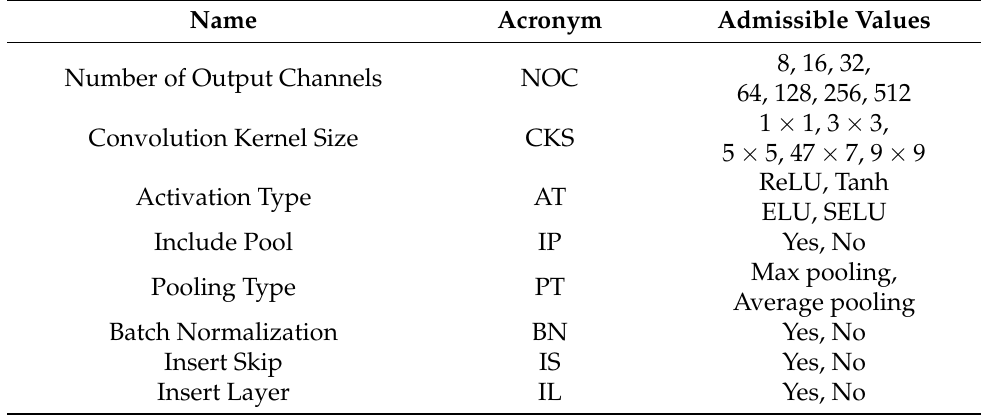
Table 2. Hyperparameters emphasised during the evolution of the